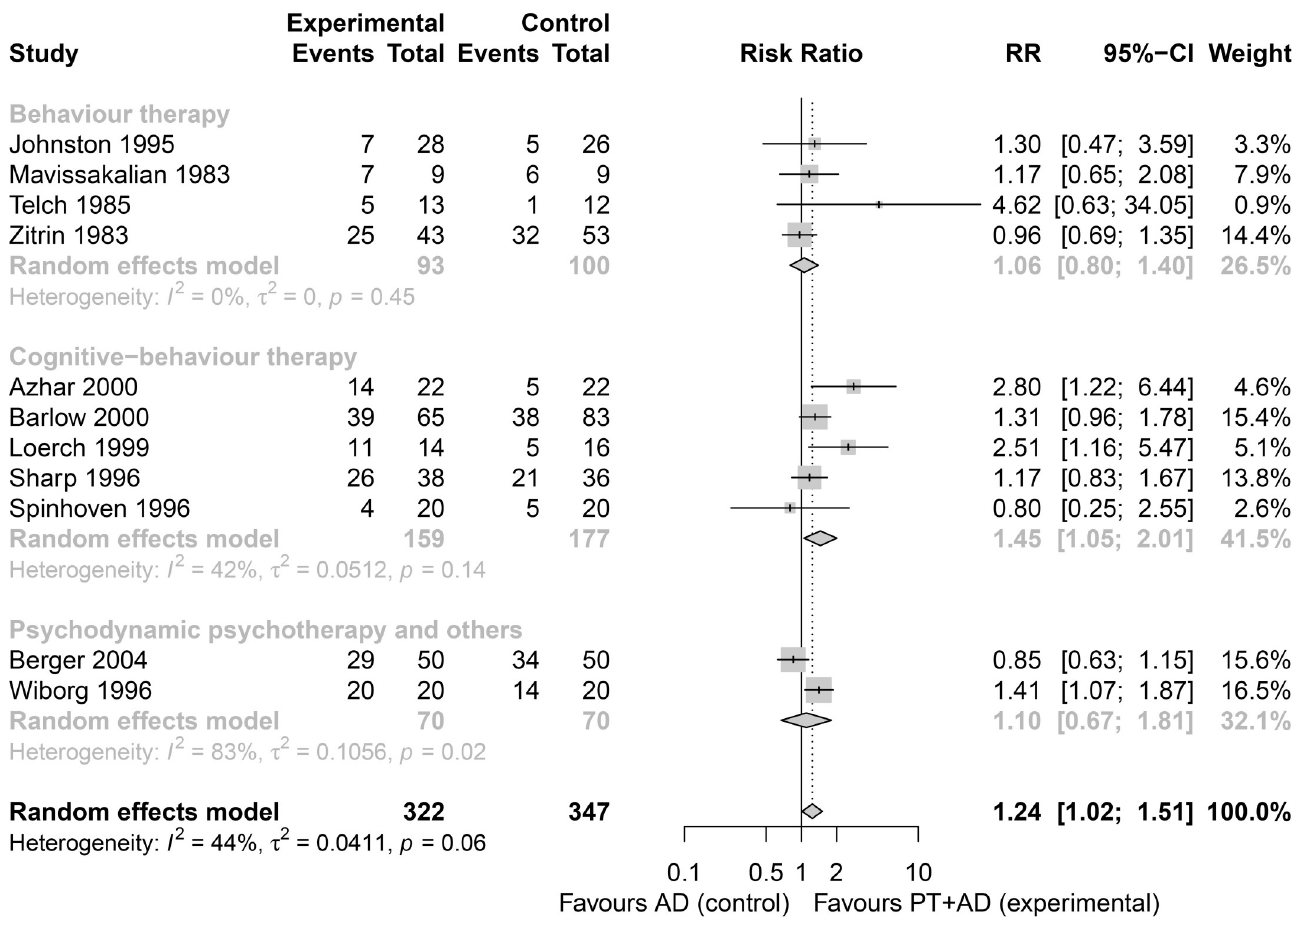
Fig 1. Forest plot for a subgroup of studies that compared combined PT+AD versus AD for the rate of response (i.e. substantial improvement) at 2–4 months in patients with panic disorder with or without agoraphobia. Subgroup analysis is conducted for the three components of the combined psychotherapy: (1) Behaviour therapy , (2) Cognitive-behaviour therapy , (3) Psychodynamic psychotherapy , and others . The analysis provided with the inverse- variance random-effects model with R package meta [41]. The risk ratio was used as an effect size. Heterogeneity was estimated with the DerSimonian-Laird estimation method.